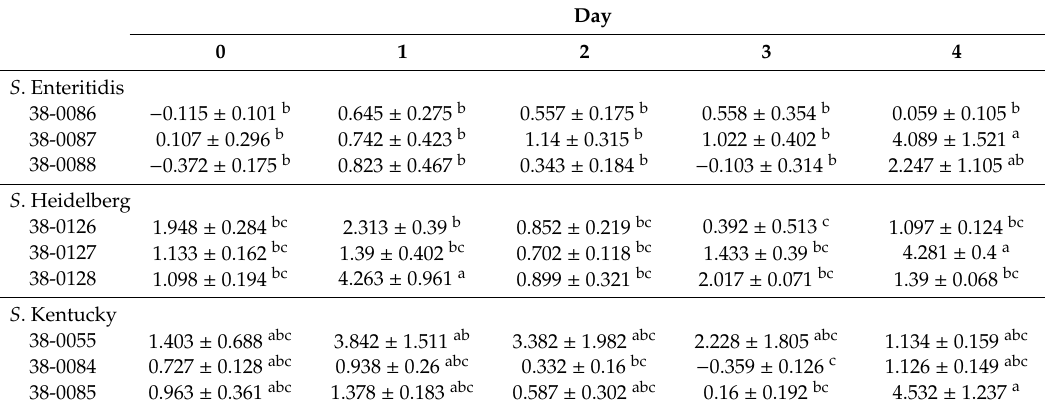
Table 4. Changes in expression of the gene bcsA from planktonic cells used to form pellicles in Salmonella Kentucky, Enteritidis, and Heidelberg over a 4-day time period 1,2,3 .